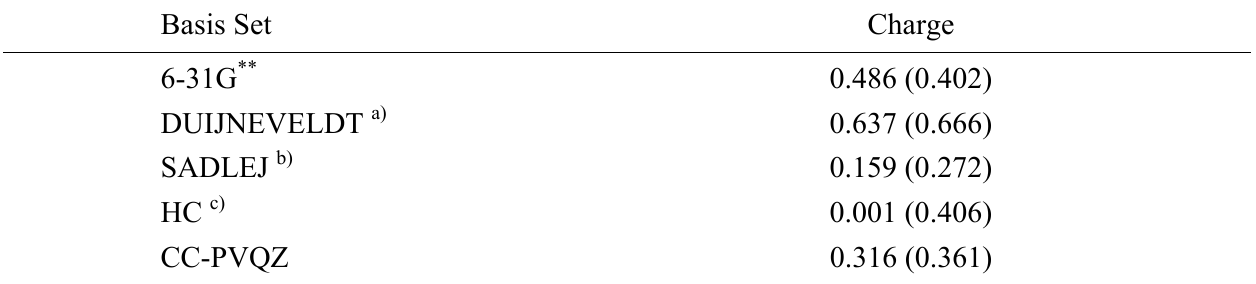
Table 1 . Mulliken ground state hydrogen bond proton charges in malonaldehyde within the different basis sets. In parentheses the respective values for the middle hydrogen bond proton position are given